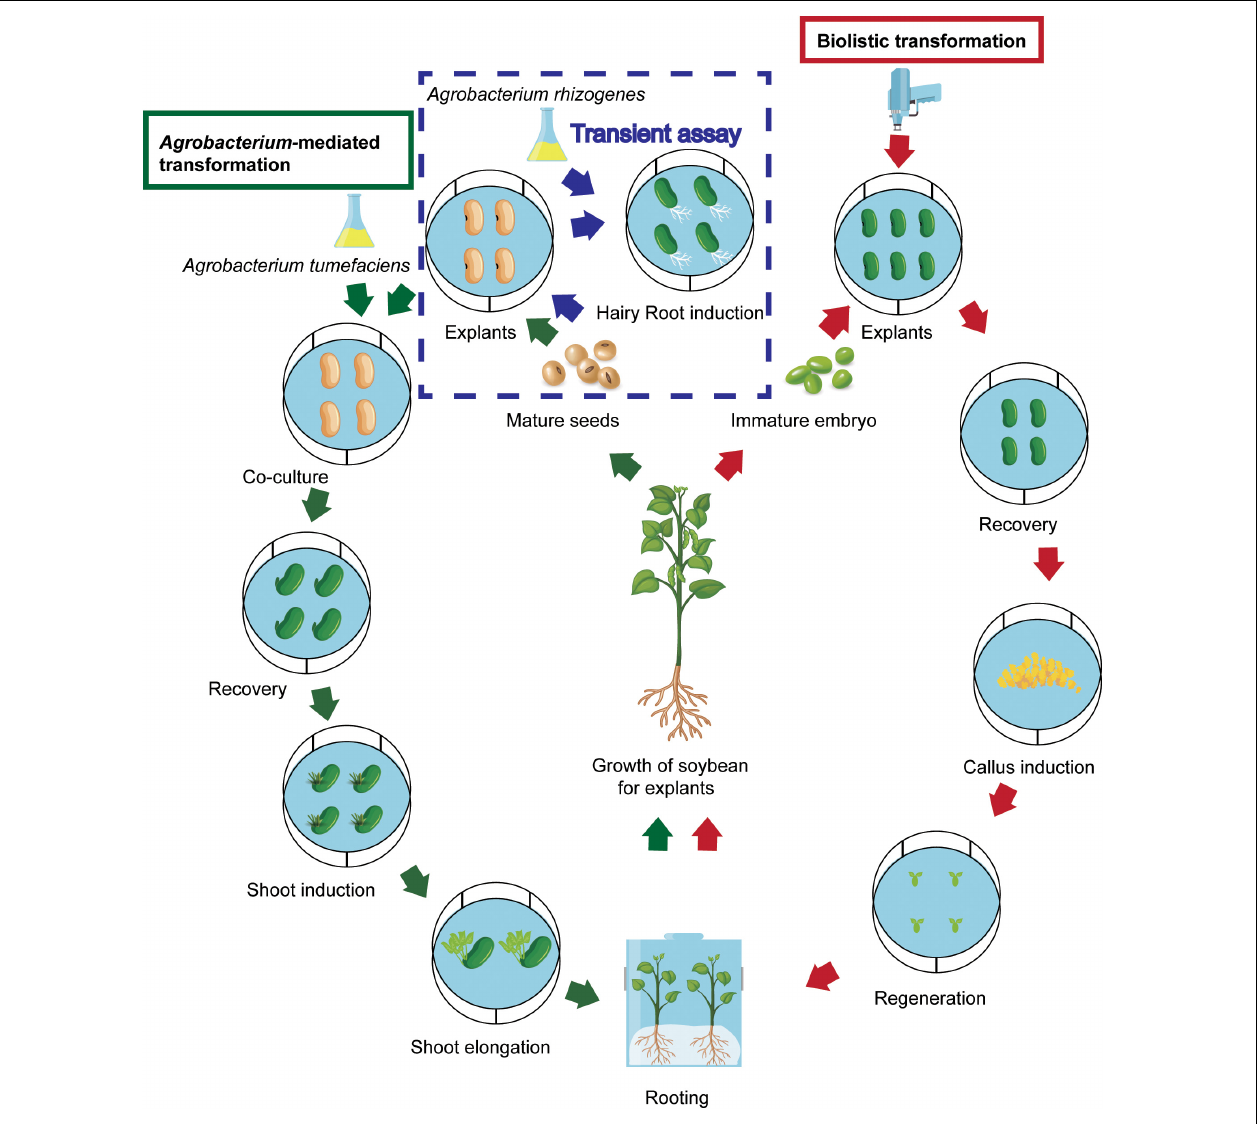
FIGURE 2 | General procedure of Agrobacterium -mediated and biolistic soybean transformation. The route following the green arrows is the Agrobacterium tumefaciens- mediated transformation procedure. The route following the red arrows is the biolistic transformation procedure. The route following the blue arrows in the frame with broken blue line shows Agrobacterium rhizogenes -mediated transformation for transient